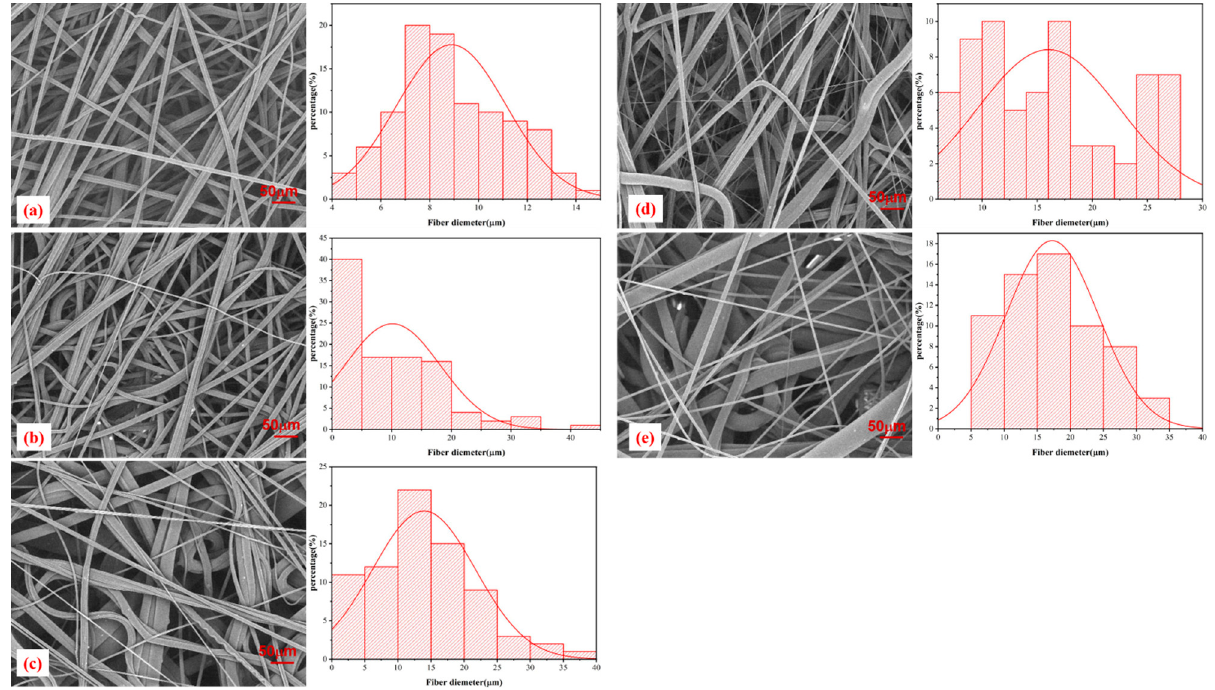
Figure 3. SEM images of melt-blown nonwoven fabrics: ( a ) PP, ( b ) PP-6, ( c ) PP-10, ( d ) PP-14, and ( e )